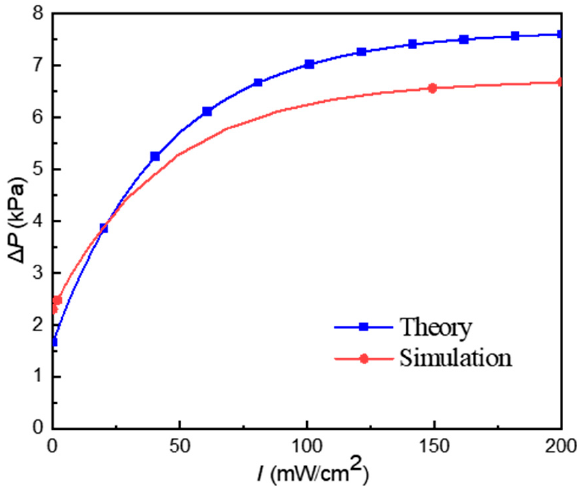
Figure 14. Comparison of the theoretical and simulation results.